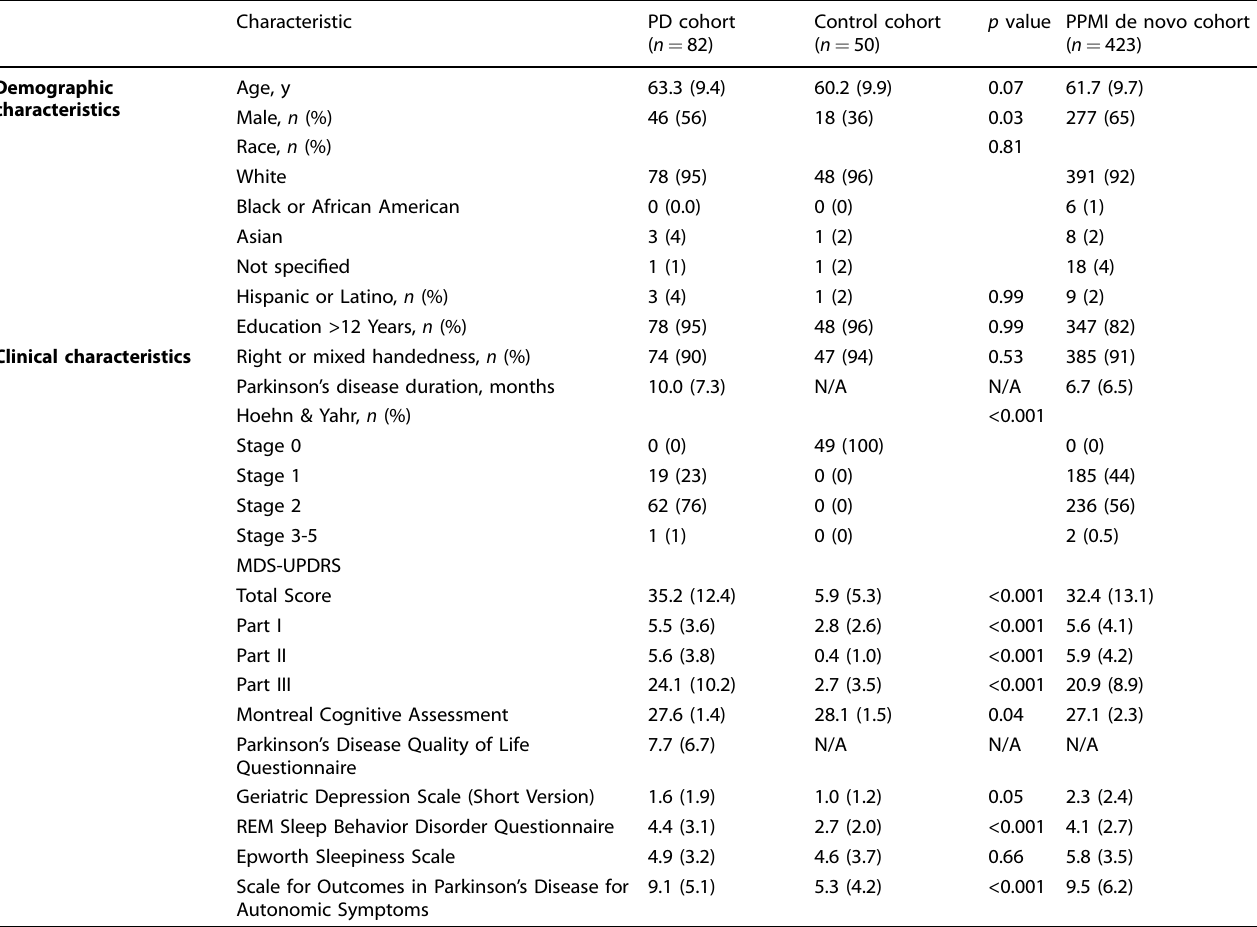
Table 1. Baseline characteristics of research participants in this study and de novo Parkinson ’ s disease participants in the Parkinson ’ s Progression Markers